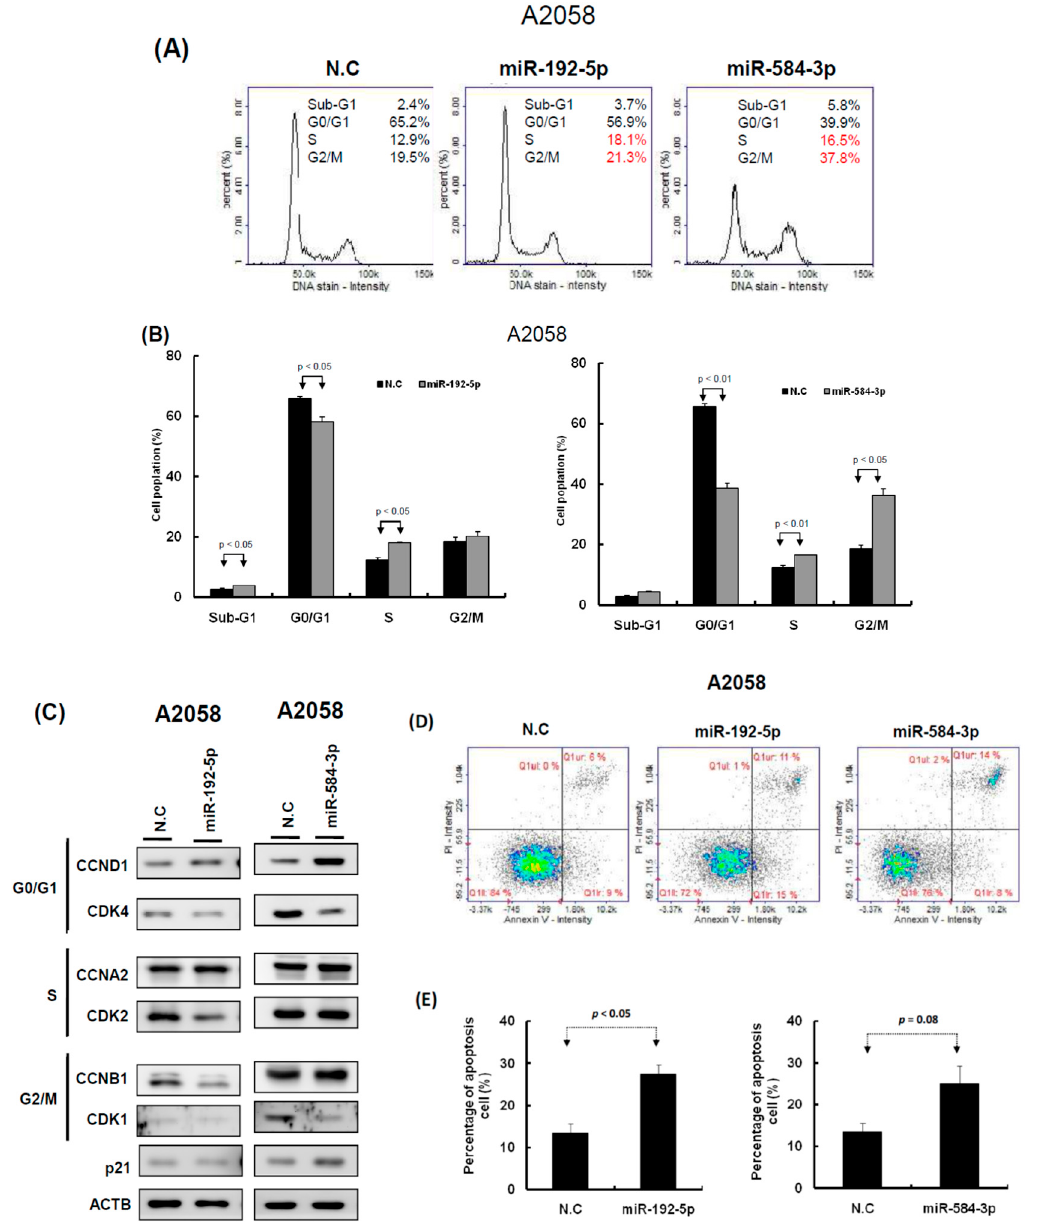
CellTiter-Glo One solution assay.